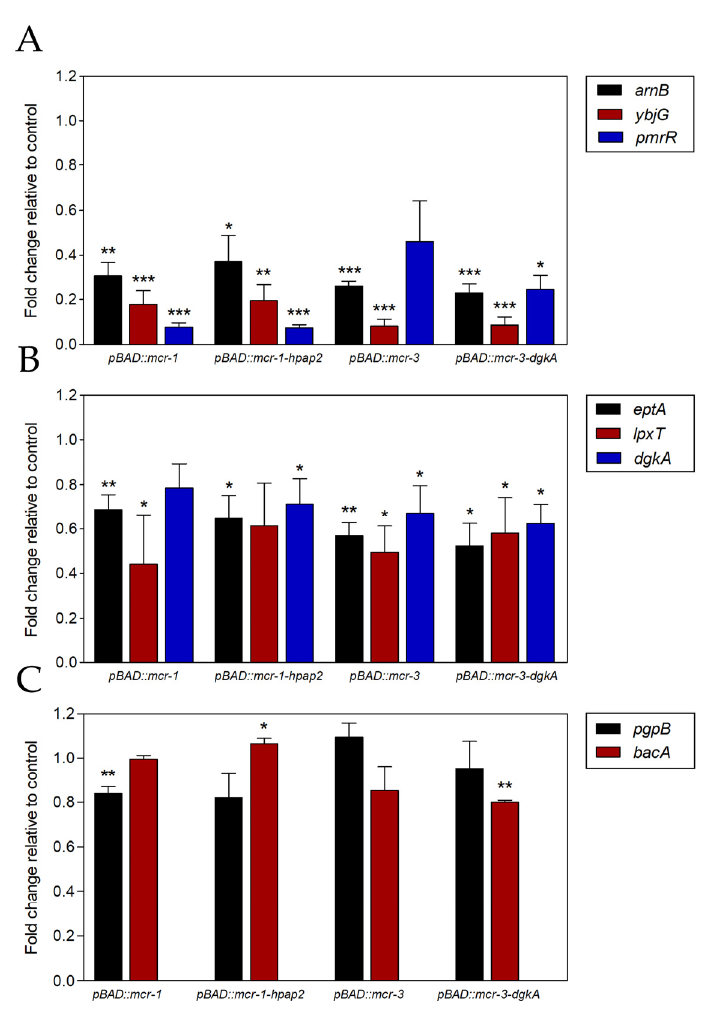
Figure 5. mRNA accumulation for phospholipid metabolism enzymes after expression of mcr-1–hpap2 and mcr-3–dgkA gene constructs. Gene expression was quantified by qPCR with primers and conditions mentioned in Table 1, whereas cell growth and induction, RNA extraction, cDNA synthesis, amplification, and quantification are explained in detail in Section 4. The significance of di ff erences between every condition and control cells carrying empty pBAD24 vector is indicated by * p < 0.1, ** p < 0.05, and *** p < 0.01 (Student’s t -test). Error bars are standard deviations based on three fully independent biological replicates. Expression of genes is separately shown depending on maximal reduction achieved: ( A ) 5.0-fold; ( B ) 1.7-fold; ( C ) 1.25-fold. A weaker e ff ect was observed for dgkA , eptA , and lpxT gene expression, whose reduction was limited to 40% (1.7-fold), whereas bacA and pgpB genes shared a minimal although still significant downregulation of 20% (1.25-fold). The composition of mcr gene constructs conditioned this signaling; mcr-3 expression decreased more strongly than mcr-1 the accumulation of mRNA from ybjG , arnB , eptA , and bacA genes, whereas the mcr-1 e ff ect was higher on pmrR and pgpB gene expression. In general, little or no di ff erences were found upon comparing the co-expression of mcr-1 / -3 genes alone or linked to hpap2 or dgkA , respectively. Thus, with subtle di ff erences between mcr-1 and mcr-3 genes, their expression had a profound impact on the regulation of enzymes for phospholipid metabolism, decreasing the transcription of enzymes for decoration of lipid A with L-Ara4N and PEtN and for UPP